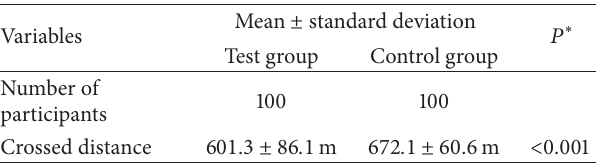
Table 3: Presentation of the groups studied with HbA1c levels lower than 8.0% and their controls in relation to the mileage meter.